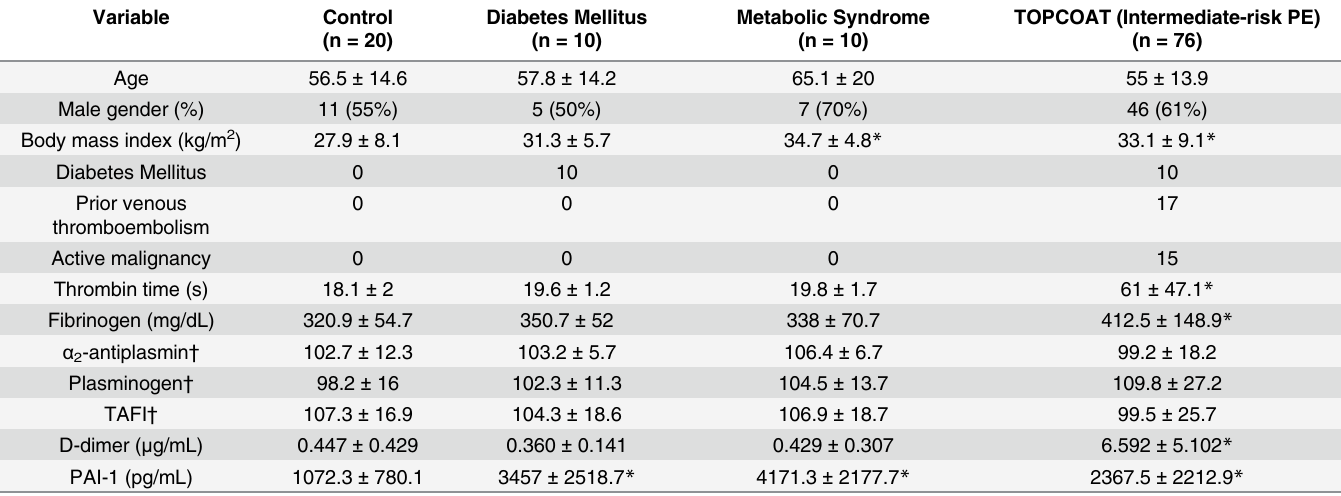
Table 1. Comparison of clinical data and plasma proteins between patient groups.